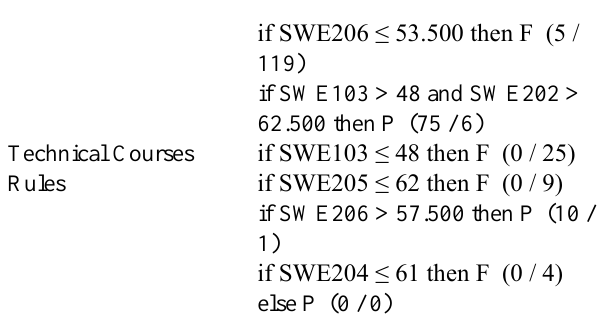
Results of Rule Induction for Dataset 1